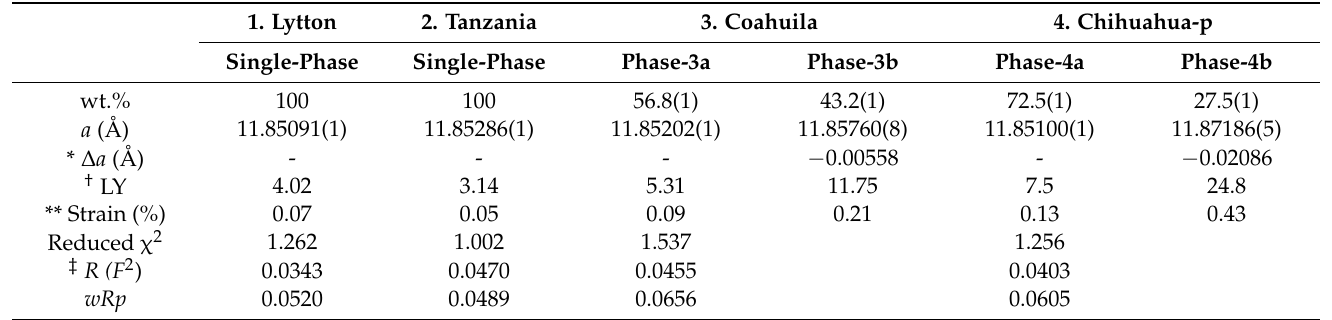
Table 2. HRPXRD data and Rietveld refinement statistics for six grossular